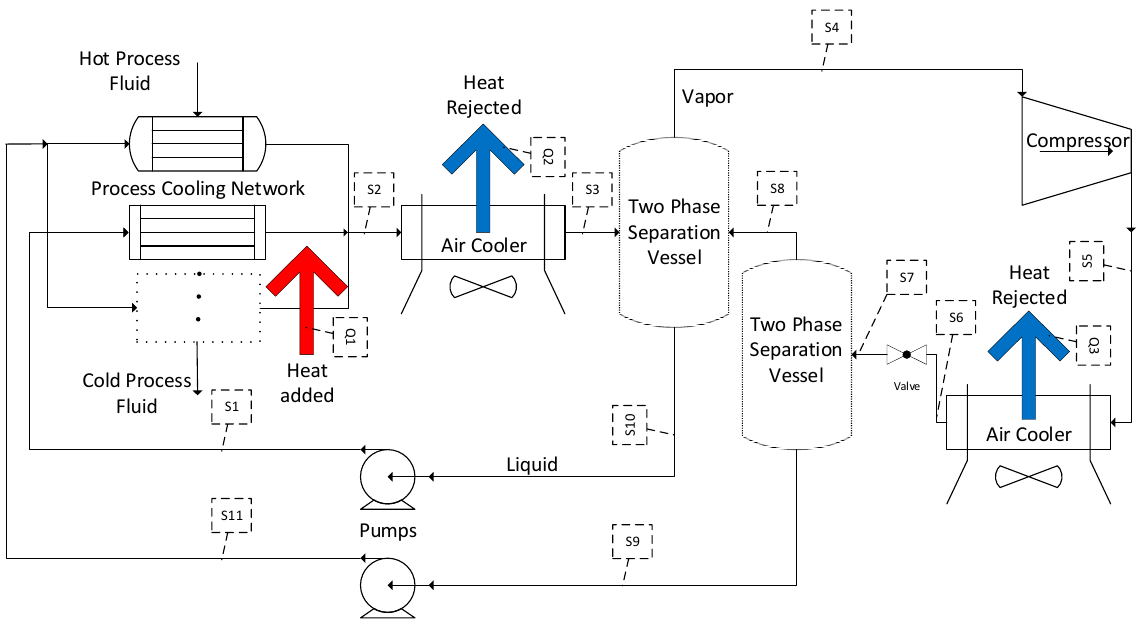
Figure 3. Concept model for a two-phase cooling fluid for a dry cooling system.